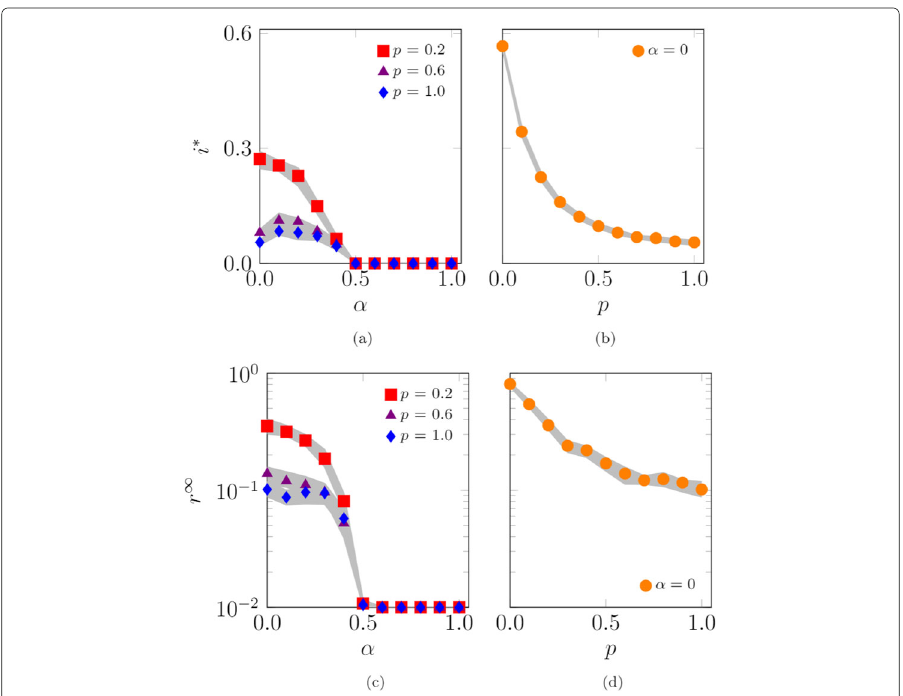
Fig. 8 Influence of the agents’ randomness, α , and the probability of jumping outside the location, p , on the endemic prevalence of the SIS model, a – b , and the epidemic size of the SIR model, c – d . Curves represent the median of 100 independent simulations; 95% confidence bands are displayed in gray. Agents are initially inside their base location and the infection starts after 100 steps to allow the agents to reach a steady-state configuration. The fraction of randomly chosen initial infected is 0.01. Other parameter values are L = 1, N = 10,000, D = 10 9 , (cid:6) min = 100, (cid:6) max = 10,000, σ min = 1, σ max = 1,000, v = 500, c = 4 · 10 − 4 , ω = 2.4, γ = 2.1, λ = 0.15, and μ =